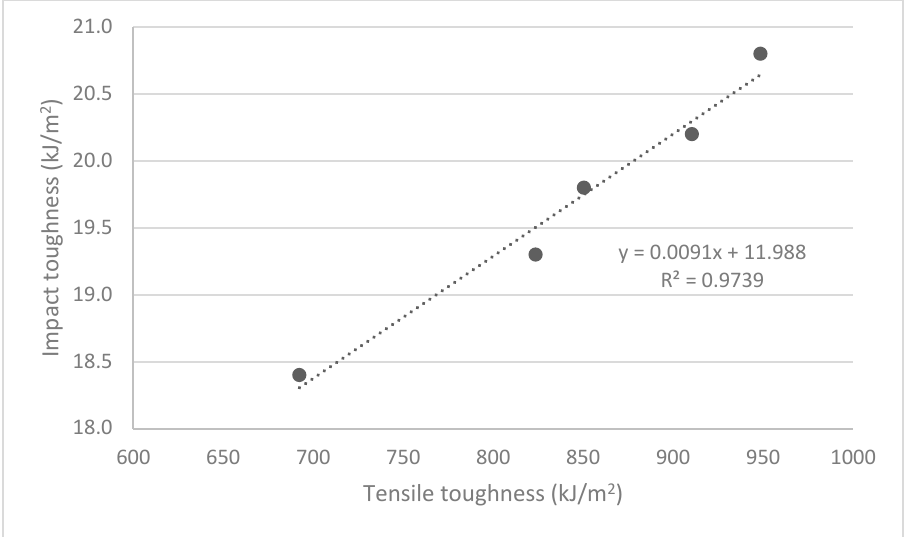
Figure 5. Correlation between the toughness of the composites obtained from tensile and impact tests.